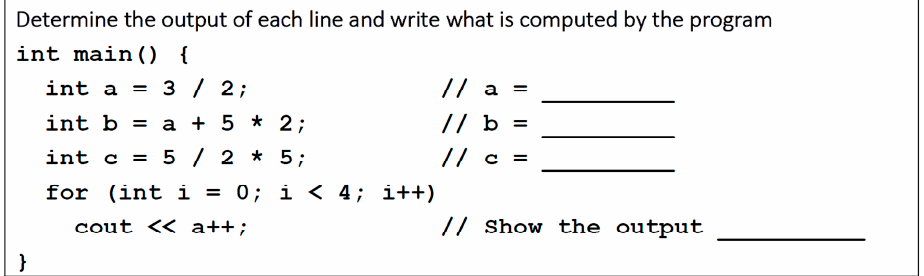
Figure 3. LiquiZ code problem specification containing random variables.